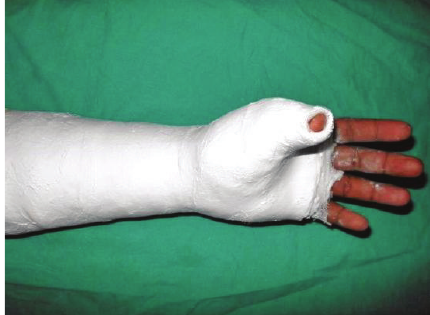
Figure 4: Post-op thumb spica cast applied.